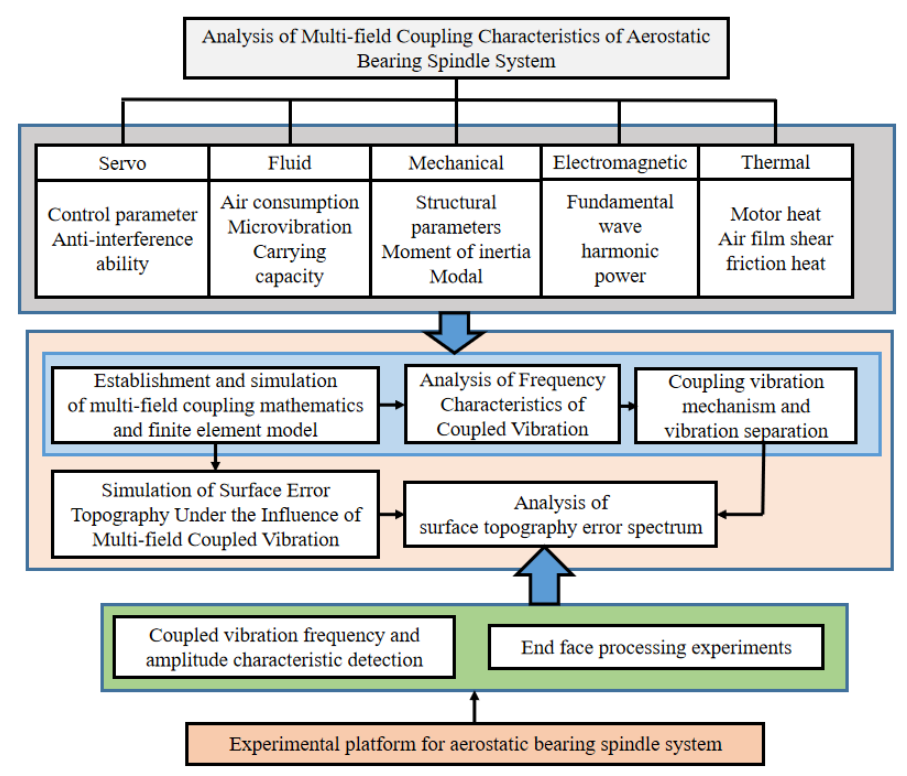
Figure 1. Flow charts of simulation and experiment of the workpiece surface topography.